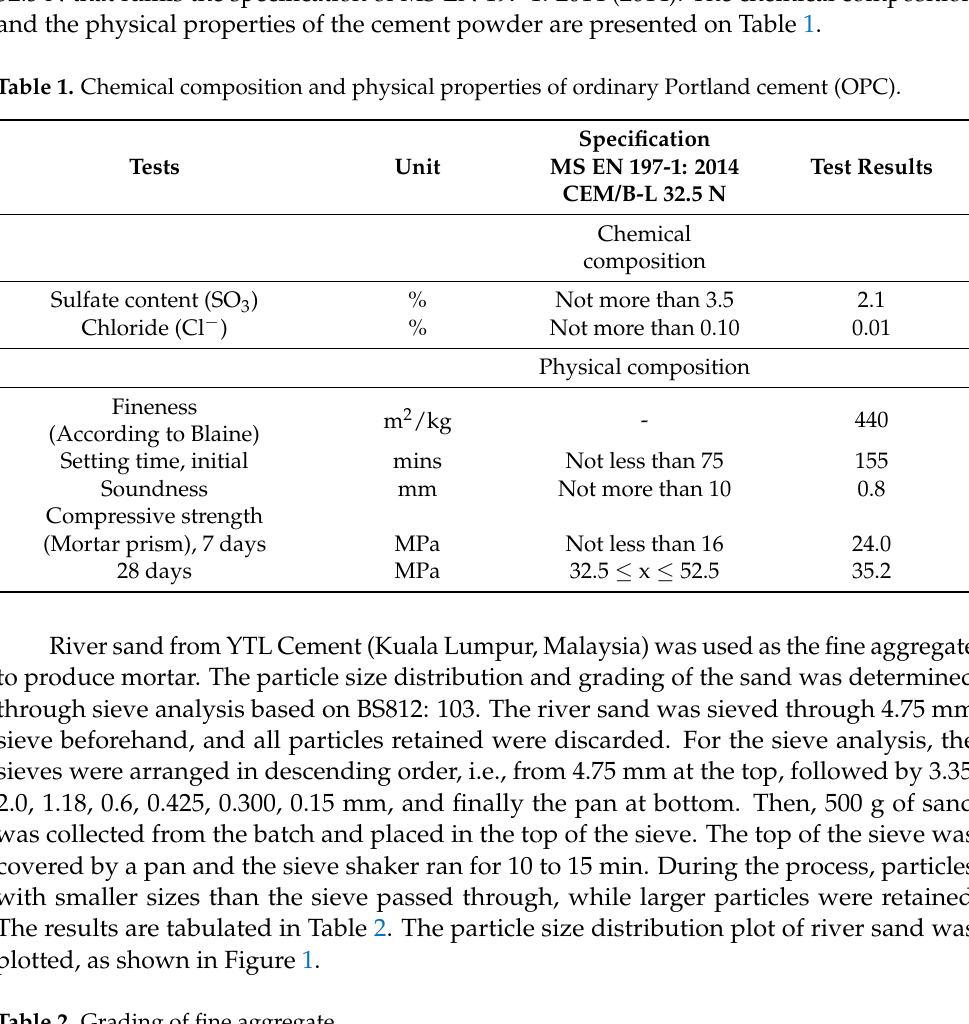
Table 2. Grading of fine